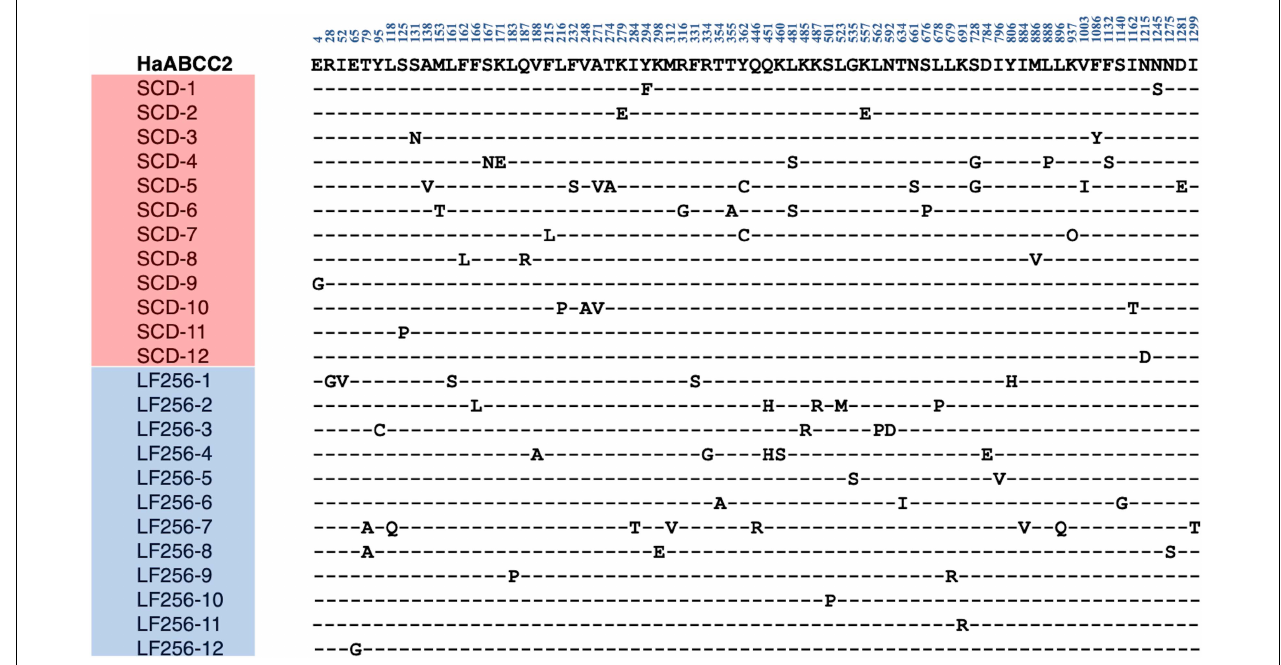
FIGURE 1 | Alignment of polymorphic amino acids predicted from sequencing cDNA of HaABCC2 from 12 larvae of susceptible strain SCD and 12 larvae of Cry1Ac-resistant strain LF256 of H. armigera. Dashes indicate the amino acids are the same as in the SCD GenBank sequence (MW592372, top line in bold).